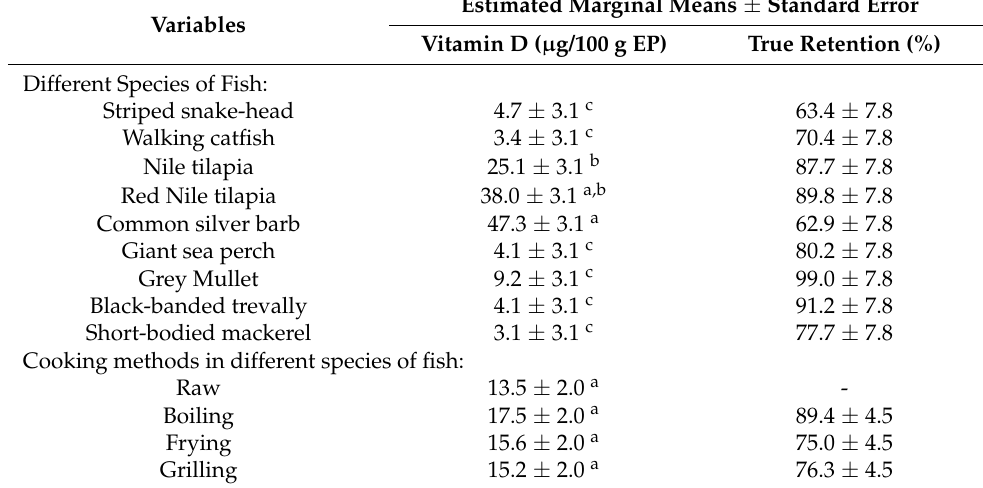
Table 5. Estimated marginal means of vitamin D content and percentage of vitamin D true retention by the main effects of different species of fish and cooking methods (calculated from two-way ANOVA) ( n = 3).